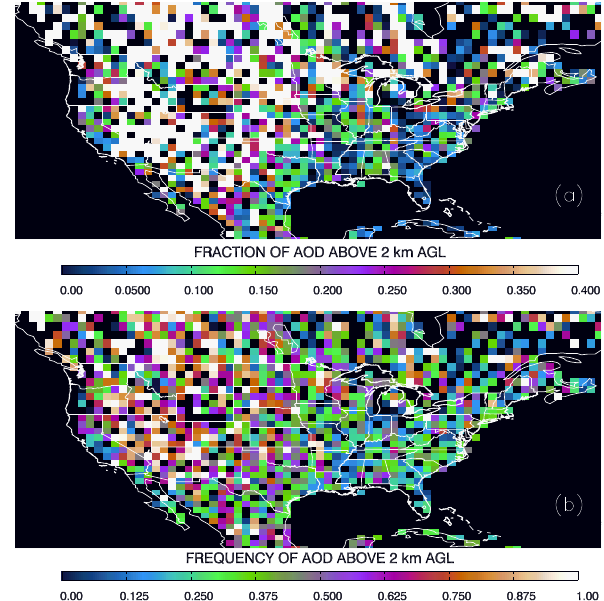
Figure 9. Two-year (2008–2009) 1 ◦ × 1 ◦ average (a) contribution percentage of above 2km a.g.l. CALIOP AOD to total column AOD (at 0.532µm) and (b) frequency of occurrence of AOD above 2km a.g.l., both relative to the number of cloud-free CALIOP pro- files in each 1 ◦ × 1 ◦ bin, for the contiguous United